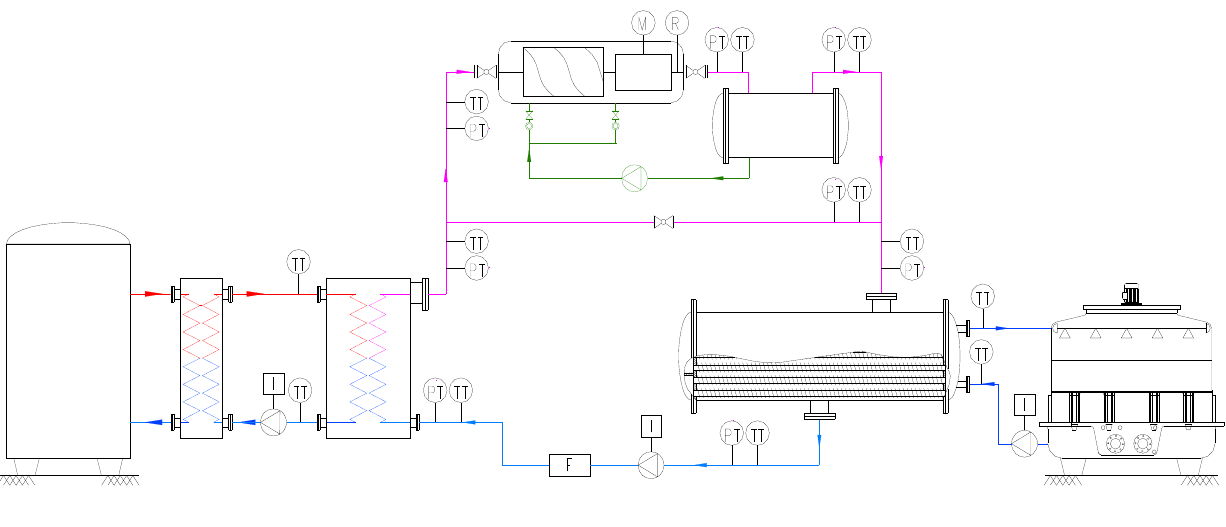
Figure 1. Schematic diagram of 50-kW ORC system used in this study.